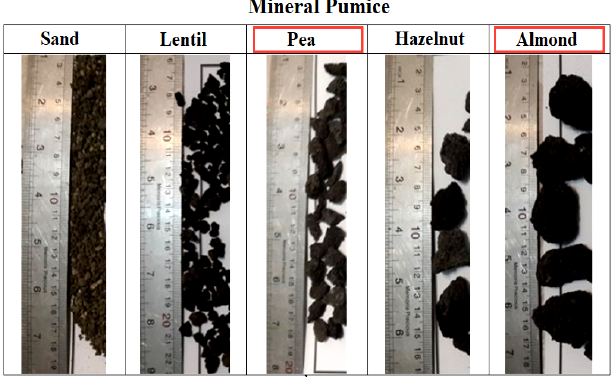
Figure 6: Various granulation of pumices.